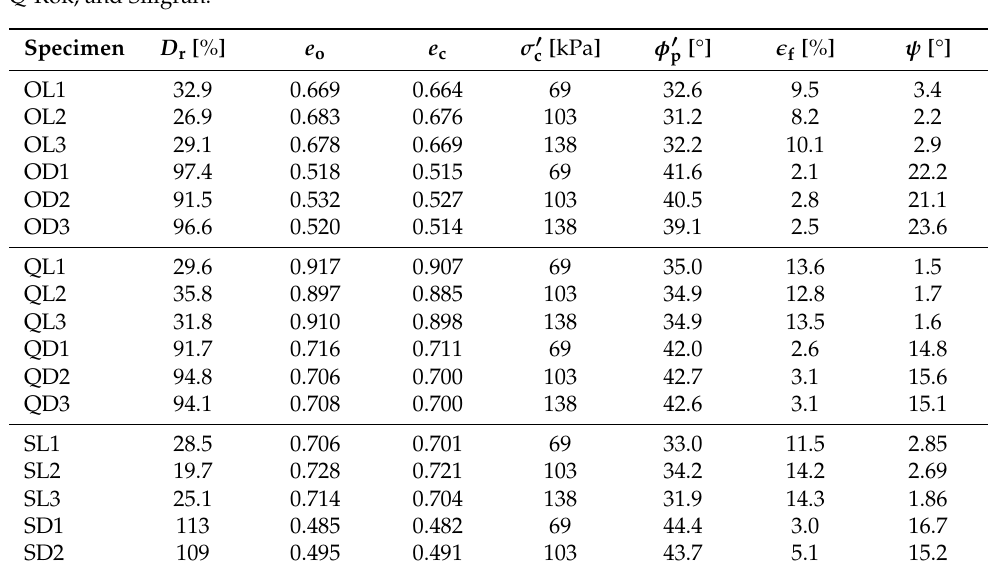
Figure 13. Response of Euroquarz Siligran to drained triaxial compression: ( a ) Stress–strain relation- ship, ( b ) Volumetric relationship. Table 3. Initial states, and results of consolidated drained triaxial compression of Ottawa sand, Q-Rok, and